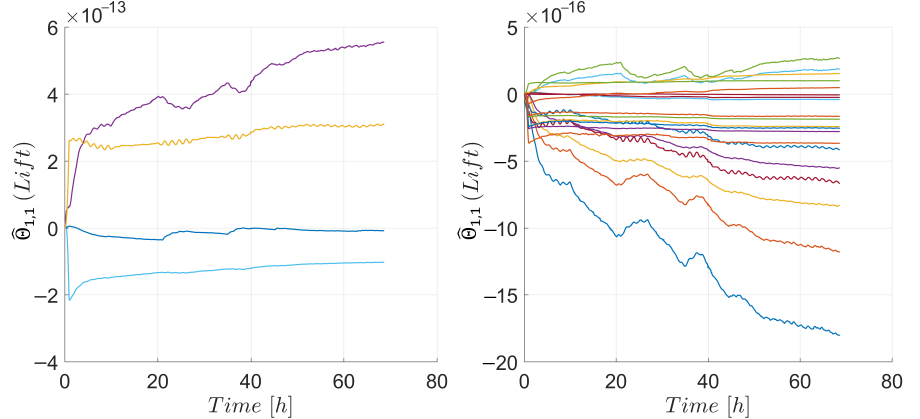
Figure 14. Parameter estimates from the attitude controller associated with the aerodynamic lift of the chaser. Components (cid:98) B 1 (cid:98) C L , j of (cid:98) Θ 1 , 1 with j = 1,2,3,4 ( left ), remaining components of (cid:98) Θ 1 , 1 ( right ).